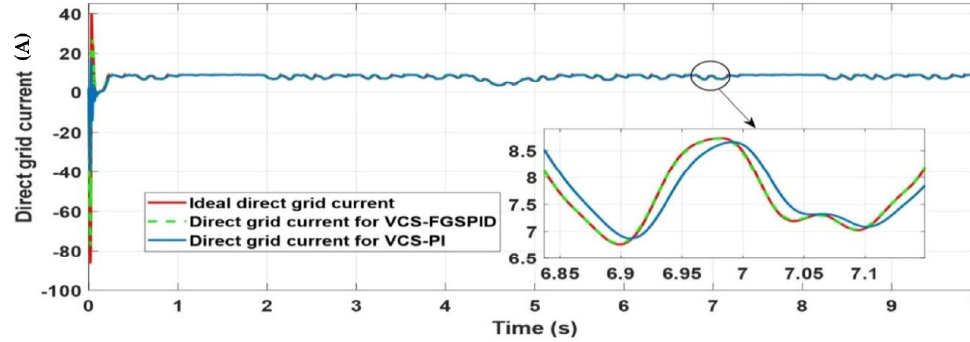
Figure 25. DC component injected into grid.